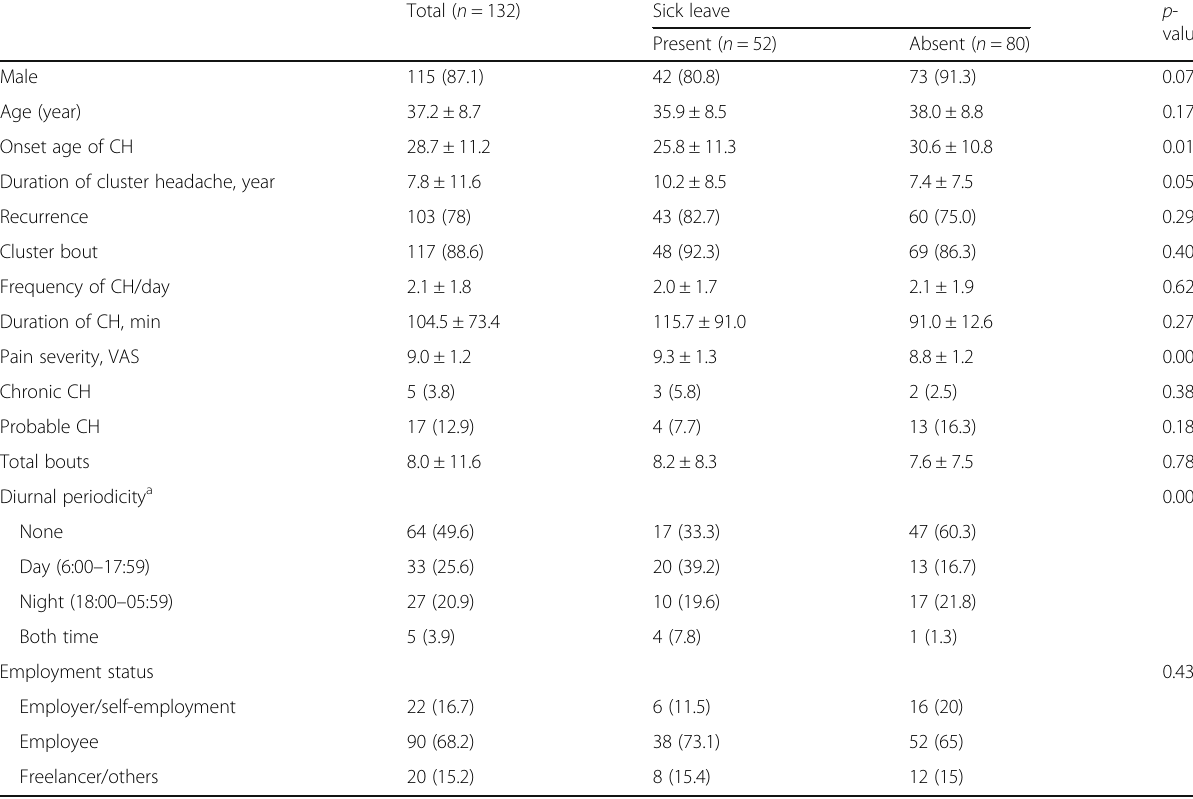
Table 4 Difference of cluster features according to experience of sick leave among 132 CH patients with current